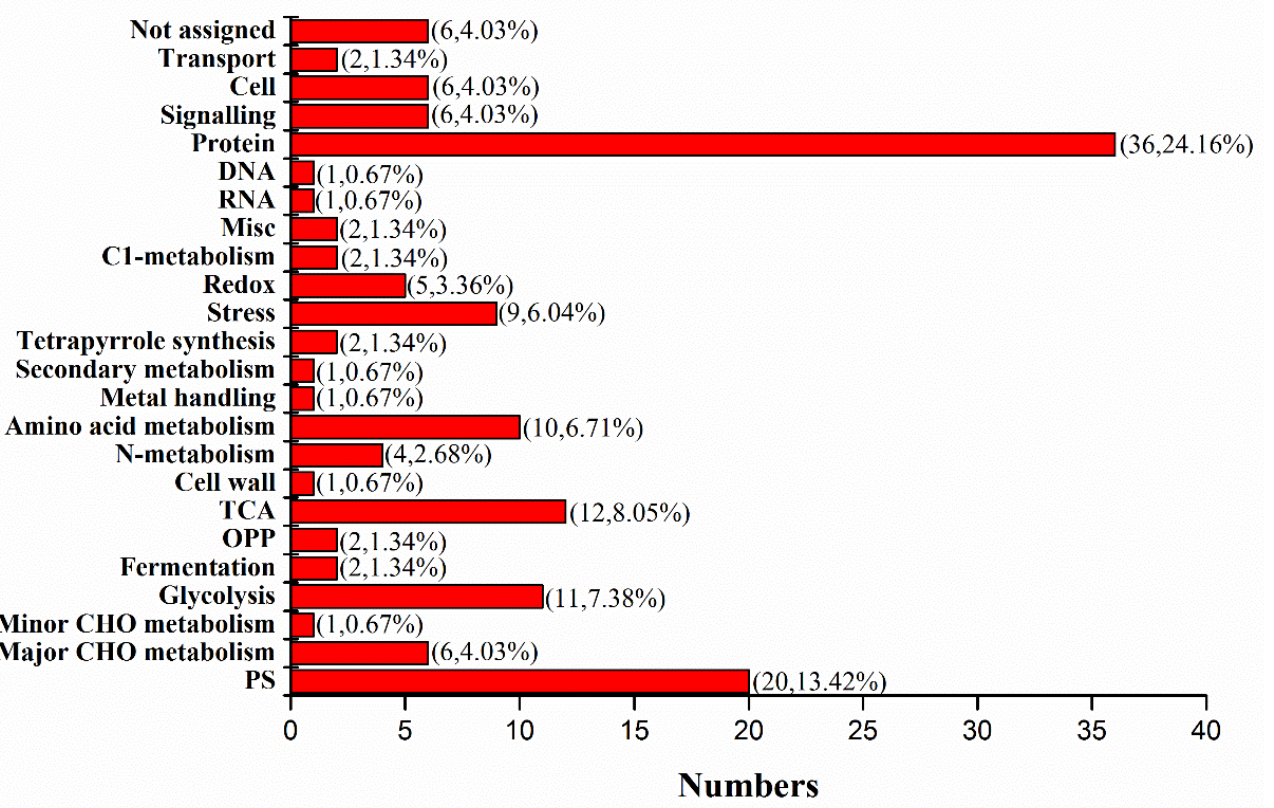
Figure 8. The functional classification of NIP client proteins.